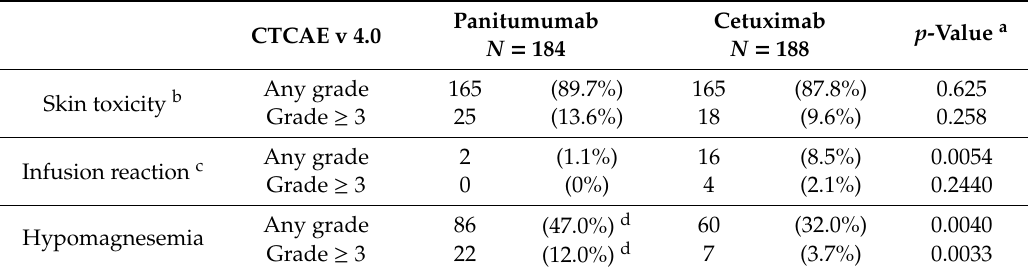
Table 3. Anti-EGFR-related adverse